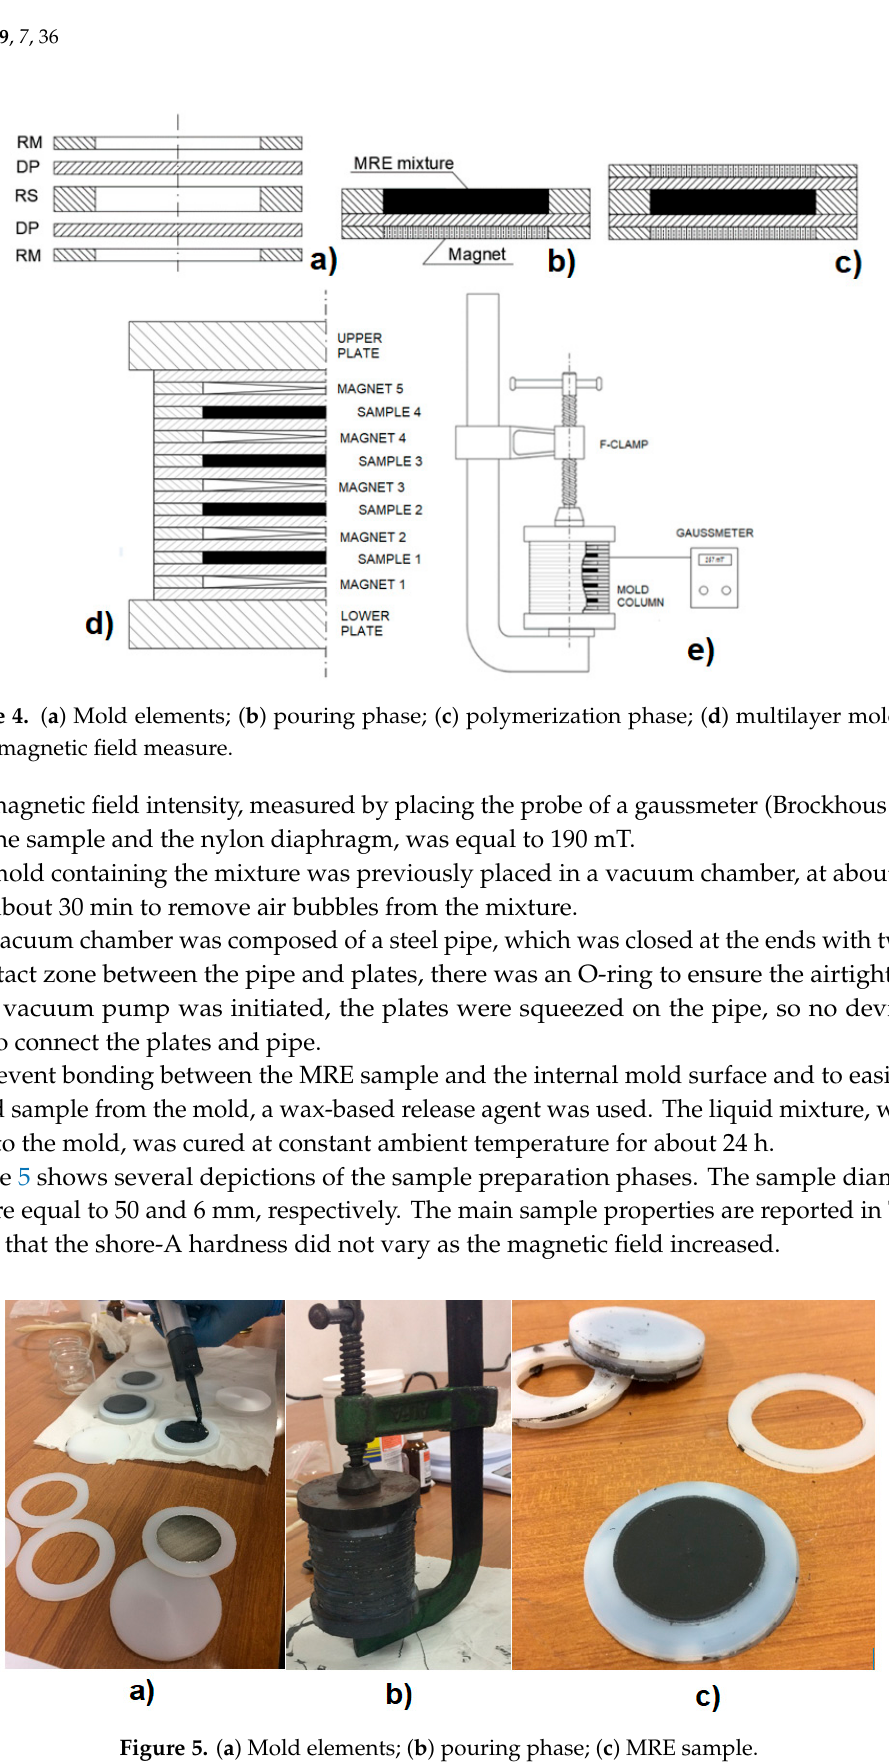
Figure 5. ( a ) Mold elements; ( b ) pouring phase; ( c ) MRE sample. Table 1. MRE sample characteristics.